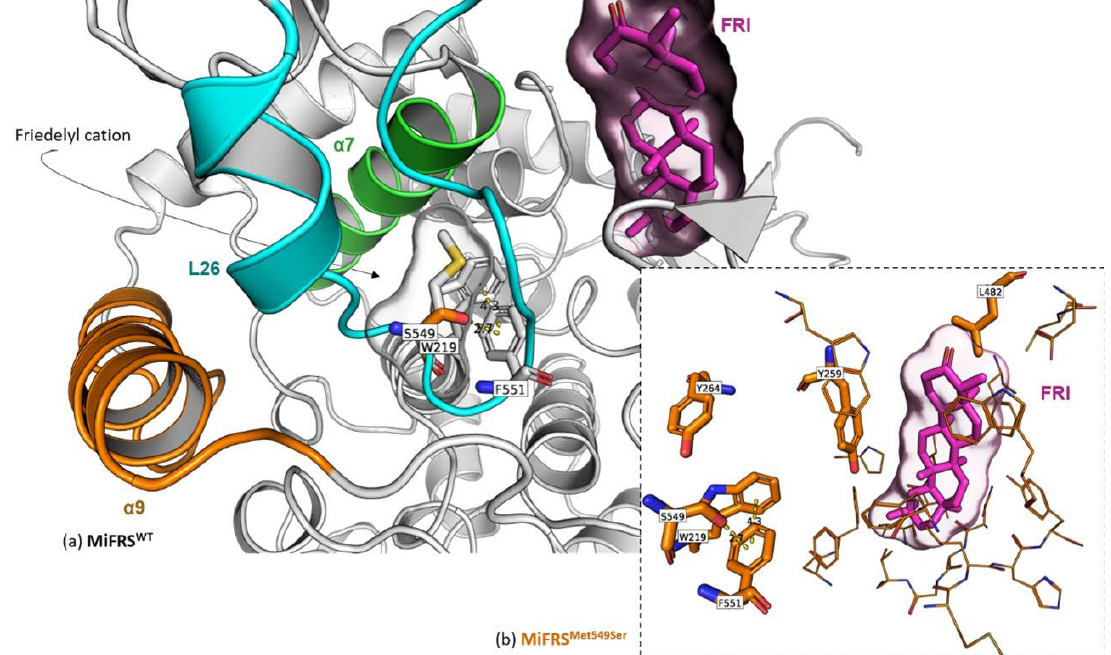
Figure 6. Secondary alignment (or side ‐ by ‐ side representation) of the wild protein ( Mi FRS) (grey stick carbons) with Mi FRS Met549Ser mutant (orange stick carbons). The surface highlights the volume adopted by the friedelin molecule in the catalytic cavity. Colored cartoons represent important protein regions: i. membrane contact α 9 (orange), ii. barrel center entrance, helix α 7 (green) and iii. catalytic loop L26. ( a ) The native Met549 occupies the route for the substrate achieves the catalytic. On the other hand, the single mutation Met549Ser stabilizes aromatic residues Tyr264 and Trp219; anion ‐π interaction between hydroxyl of Ser549 residue and the Phe551 residue is created. Interactions between the Tyr264 and Trp219 residues and the anion at the Ser549 mutated residue keep the site opened near ring C. ( b ) Stabilization of the Ser549/Phe551/Trp219/Tyr264 complex. The anion ‐π interaction is distanced by 2.7 Å, whereas the T ‐ shaped π‐π interac ‐ tion is 4.3 Å closed.